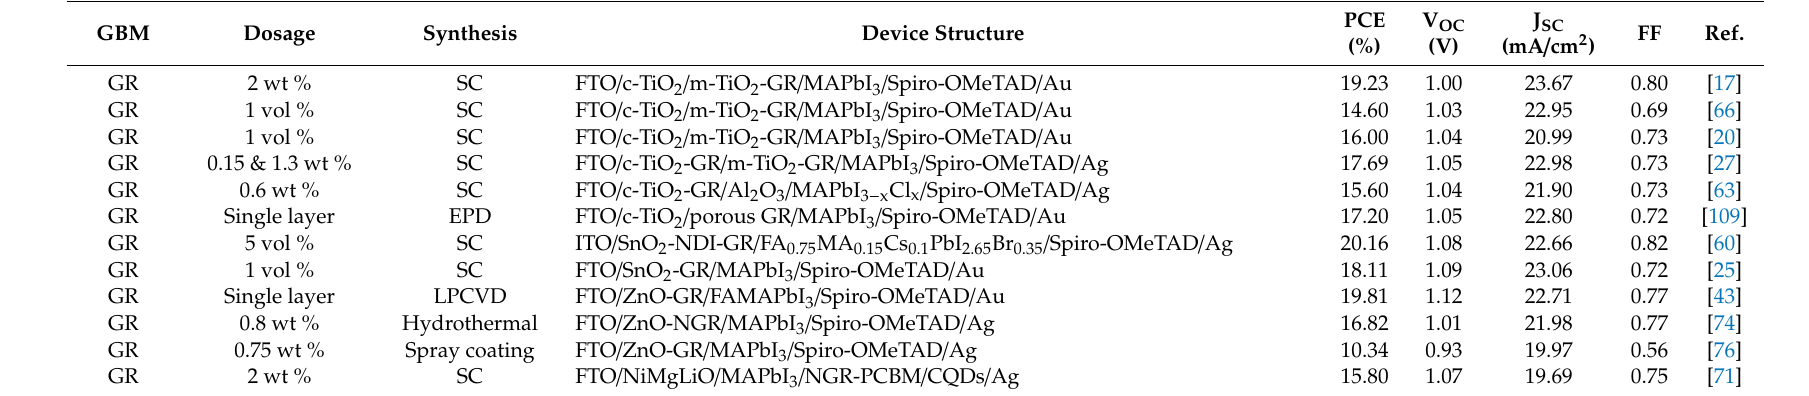
Table 2. Summary of performance of PSCs with GBM-modified